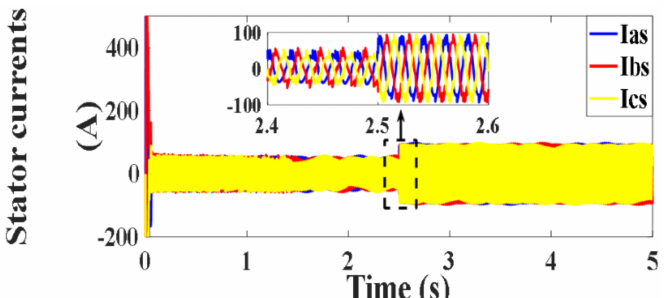
Figure 35. Stator currents under MPCC (A).